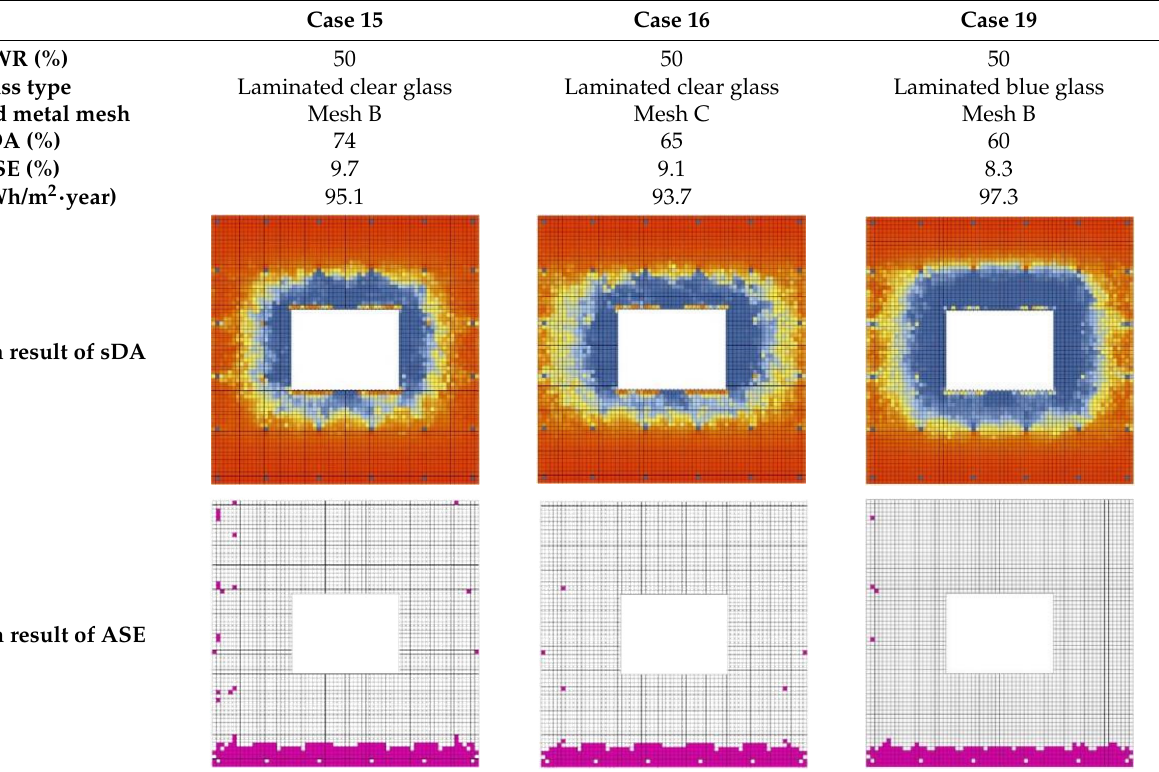
Table 11. Cases that meet LEED lighting standards.